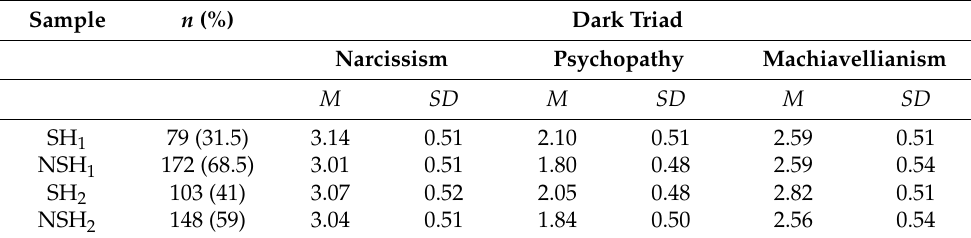
Table 6. Descriptive Statistics for the Dark Triad traits separately for those who inflicted and did not inflict electric shocks.